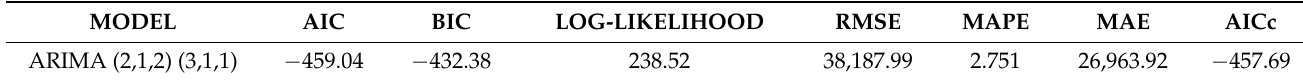
Table 6. Selection of ARIMA model for Zambia’s electricity demand.